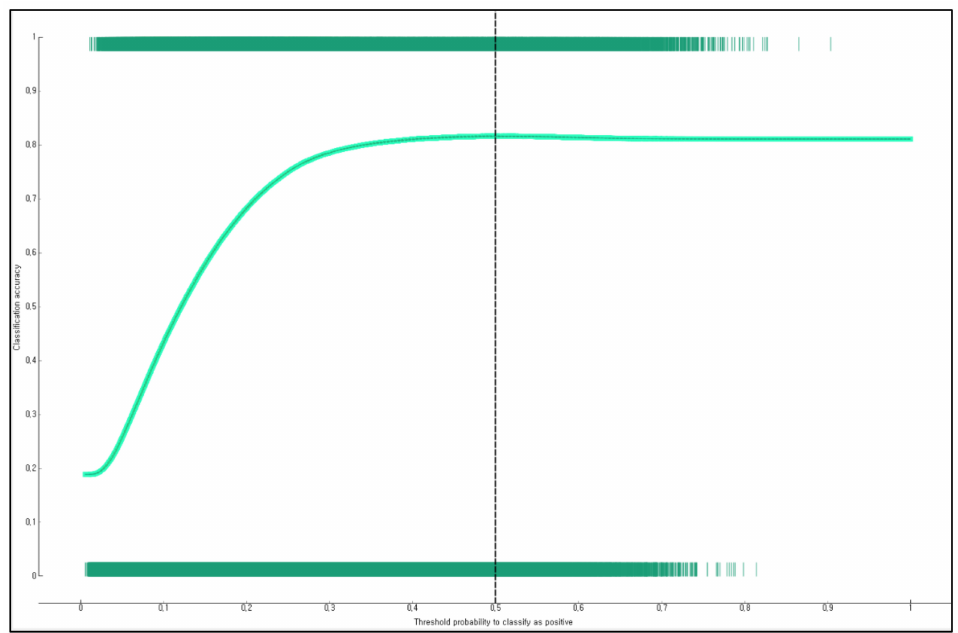
Figure 4. General accuracy of the AdaBoost-based model for predicting anxiety due to COVID-19.